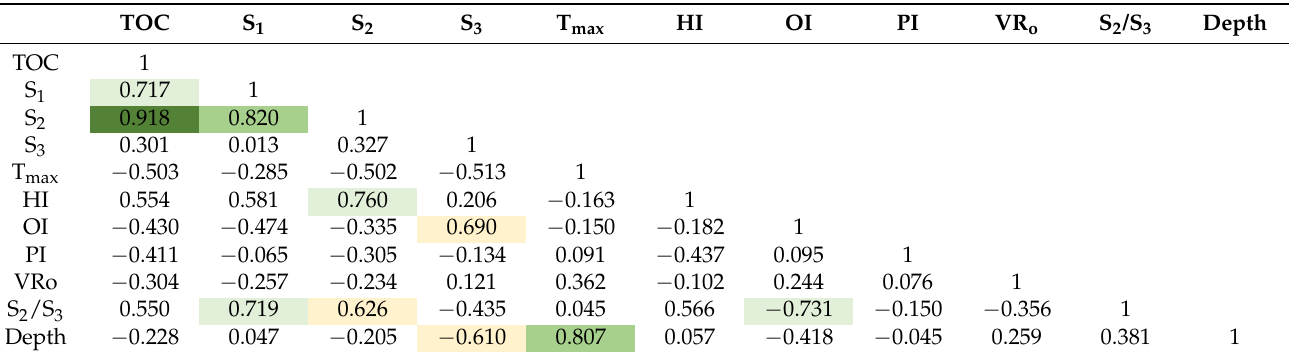
Table 3. The values of the correlation